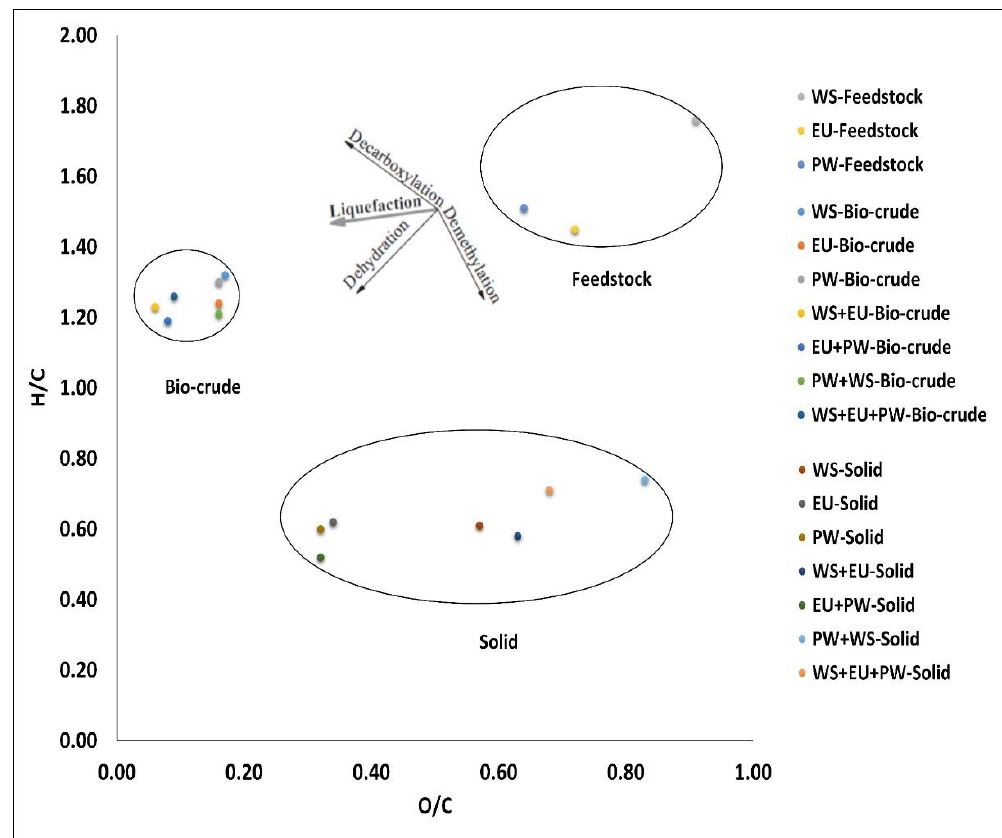
Figure 3. Energy ratios via Van Krevelen diagram.